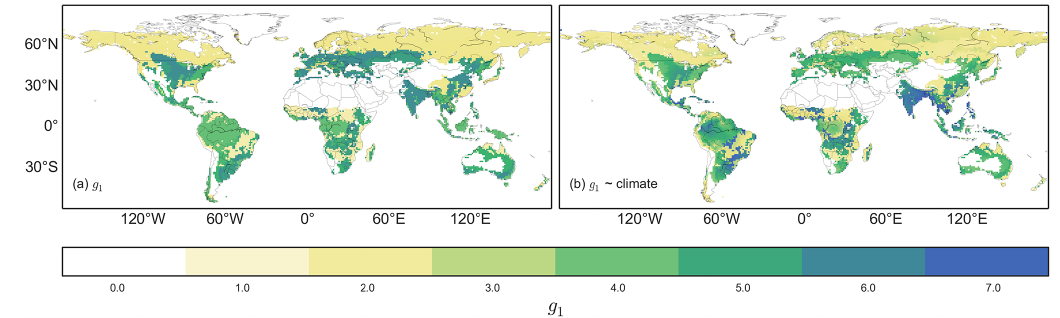
Figure 6. Global maps showing how the g 1 model parameter varies across the globe. Panel (a) shows the fitted g 1 parameter values for each PFT based on the data, panel (b) shows the predicted g 1 parameter values considering the influence of climate indices. In total, 126 out of a possible 54000 pixels have been masked from panel (b) , representing pixels where the temperature range and moisture index extended outside the range of the database of Lin et al. (2015).